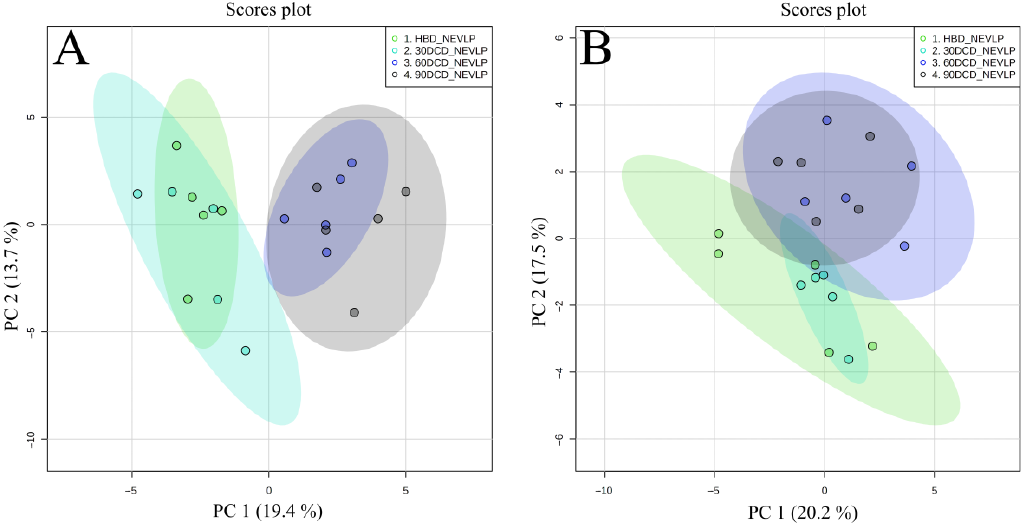
Figure 4. Score plots (PCA) showing the separation between groups with different ischemic times prior to organ harvest. ( A ) Positive ionization mode, ( B ) negative ionization